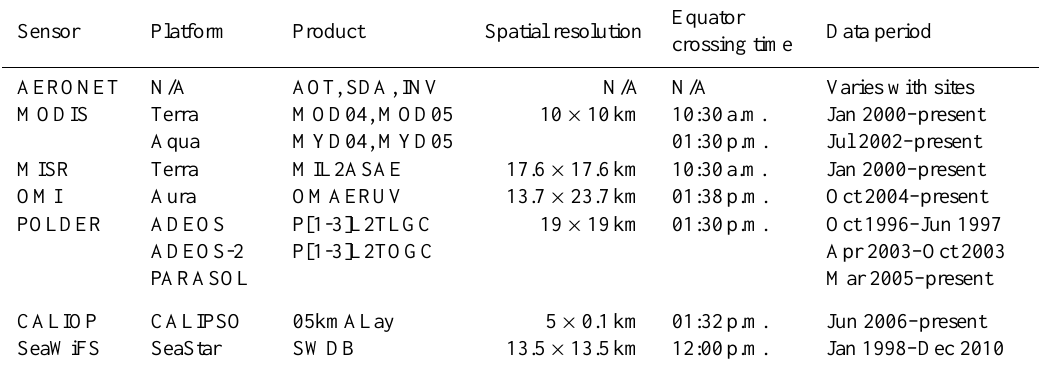
Table 1. Atmospheric aerosol measurement instruments and products supported in MAPSS. The indicated local equatorial crossing times are based on the original orbital designs, and can change during the lifetimes of the